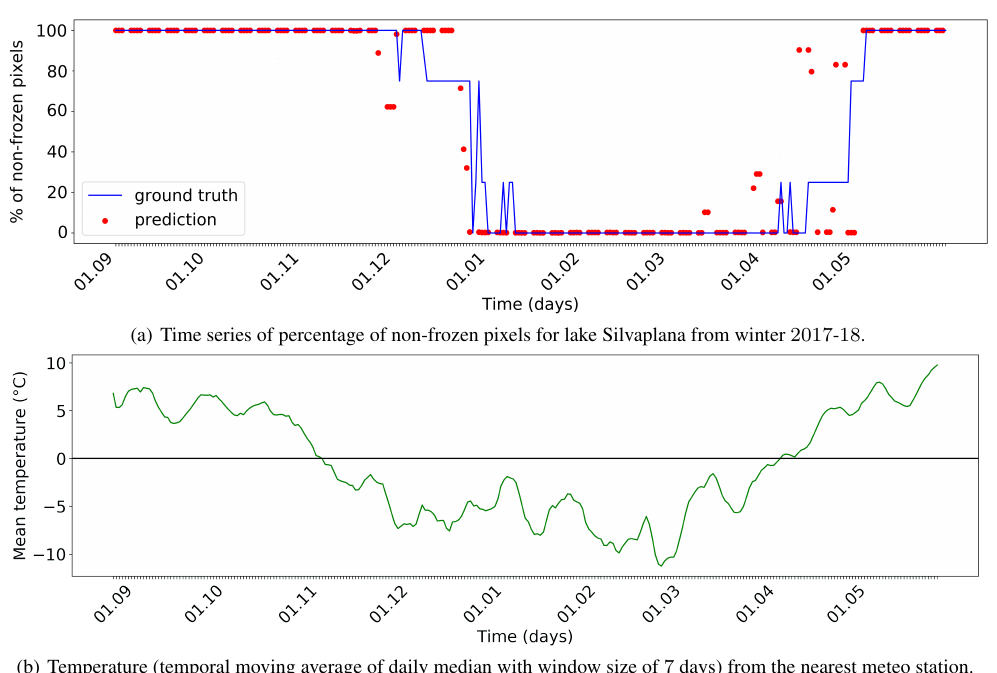
Figure 7: Correlation of our results (winter 2017 - 18 ) on lake Silvaplana with the ground truth and the auxiliary temperature data. Best if viewed on screen.